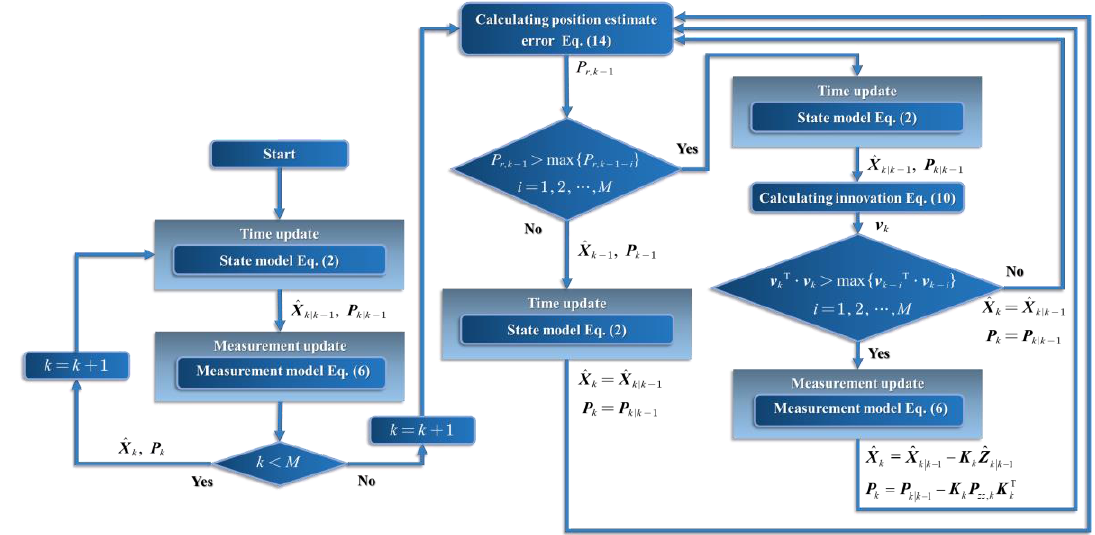
Figure 2. Parameter-independent event-triggered IUKF.